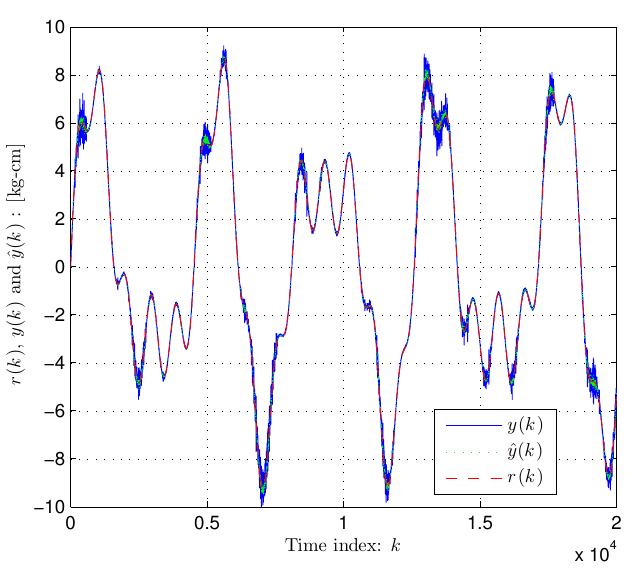
Figure 3. Tracking and model